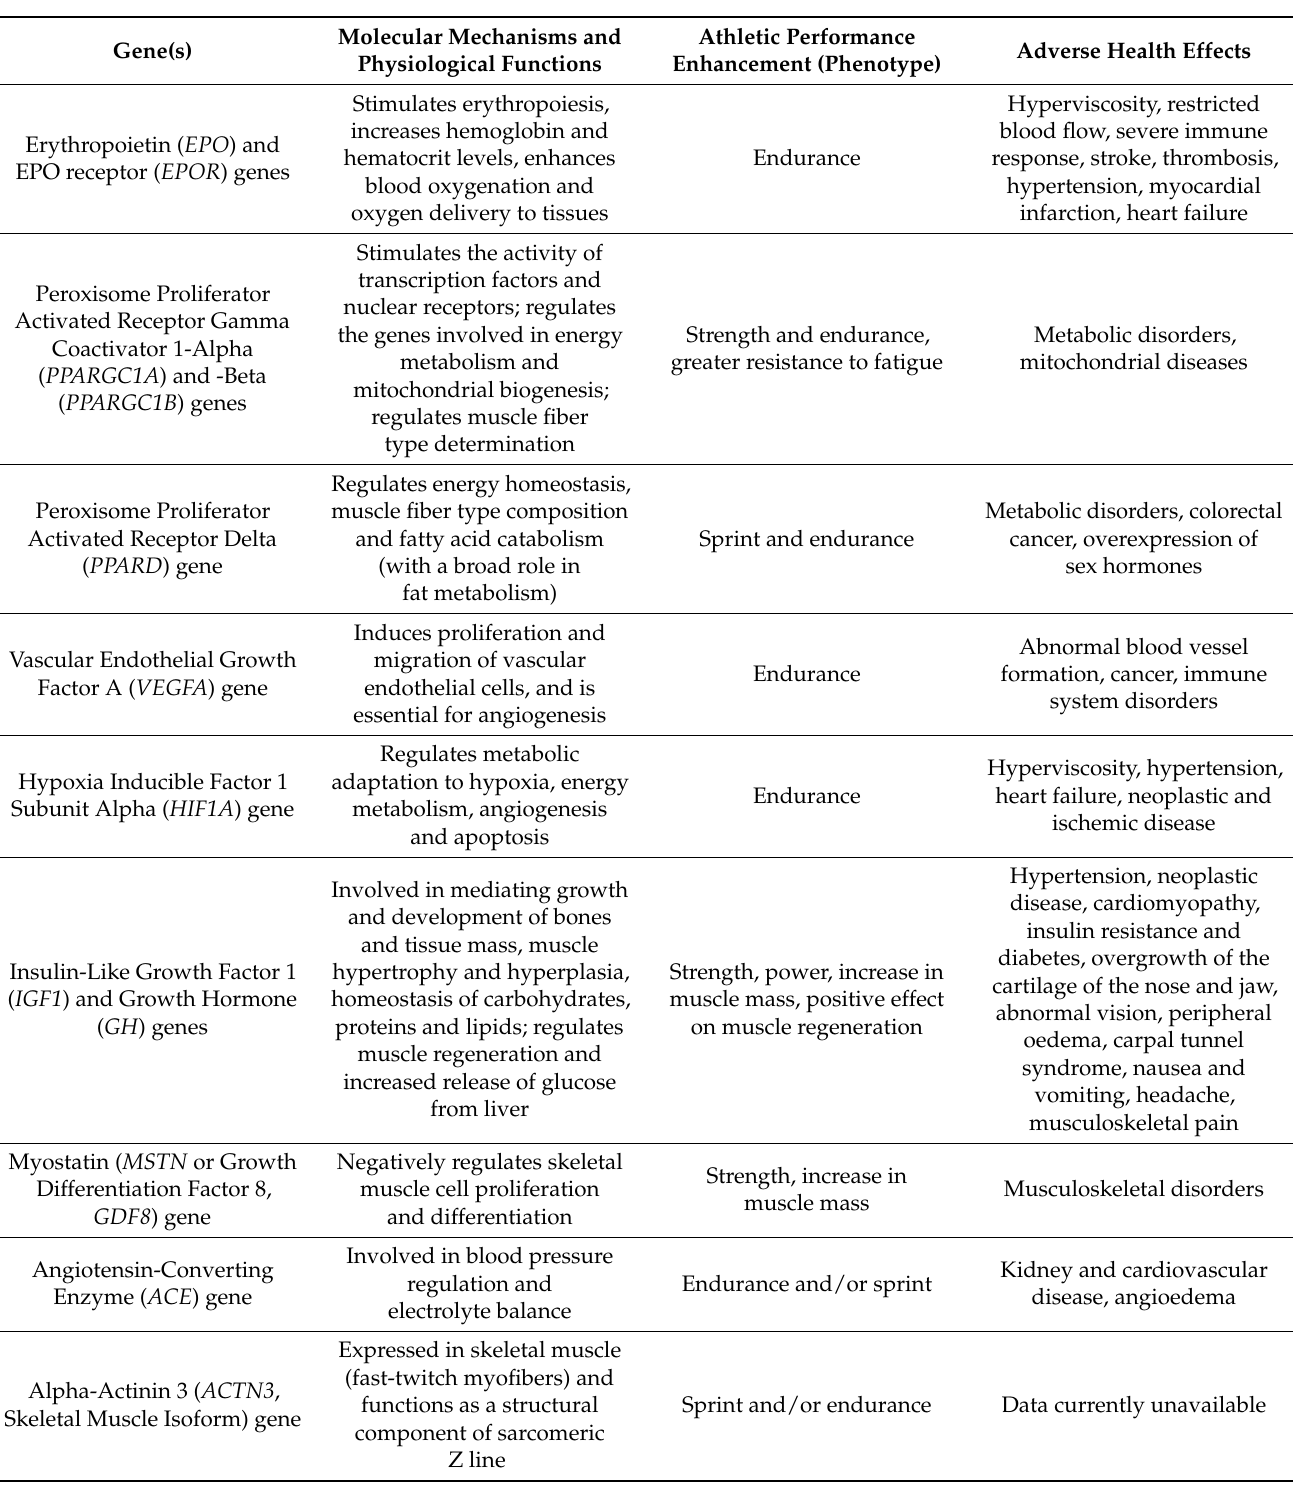
Table 1. Genes with the potential to enhance athletic performance and their potential adverse health effects [24,71,72], and information about physiological functions from The Human Gene Database (https://www.genecards.org/, accessed on 22 January